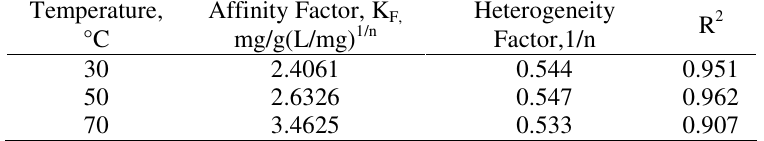
Table 4. Freundlich Constants at different temperatures for adsorption of Pb onto POFA Temperature,